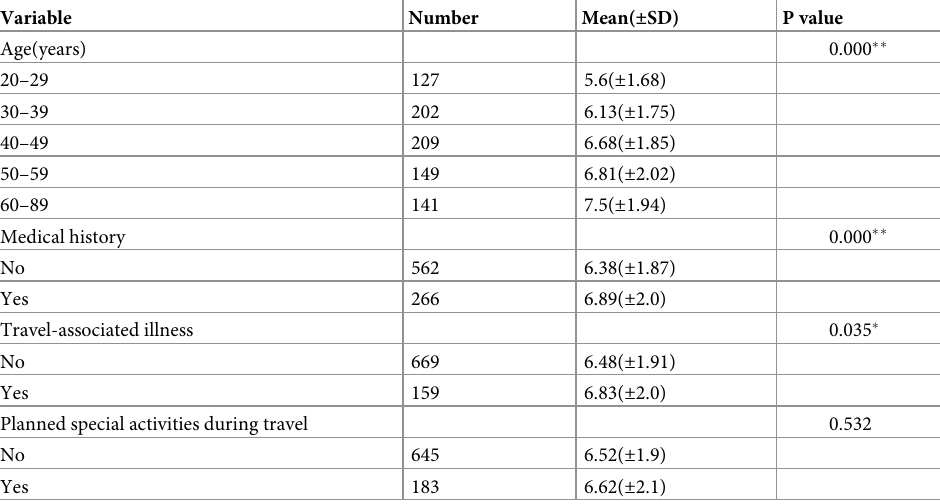
Table 3. Comparison of mean scores of knowledge of travel medicine with socio-demographic variables.